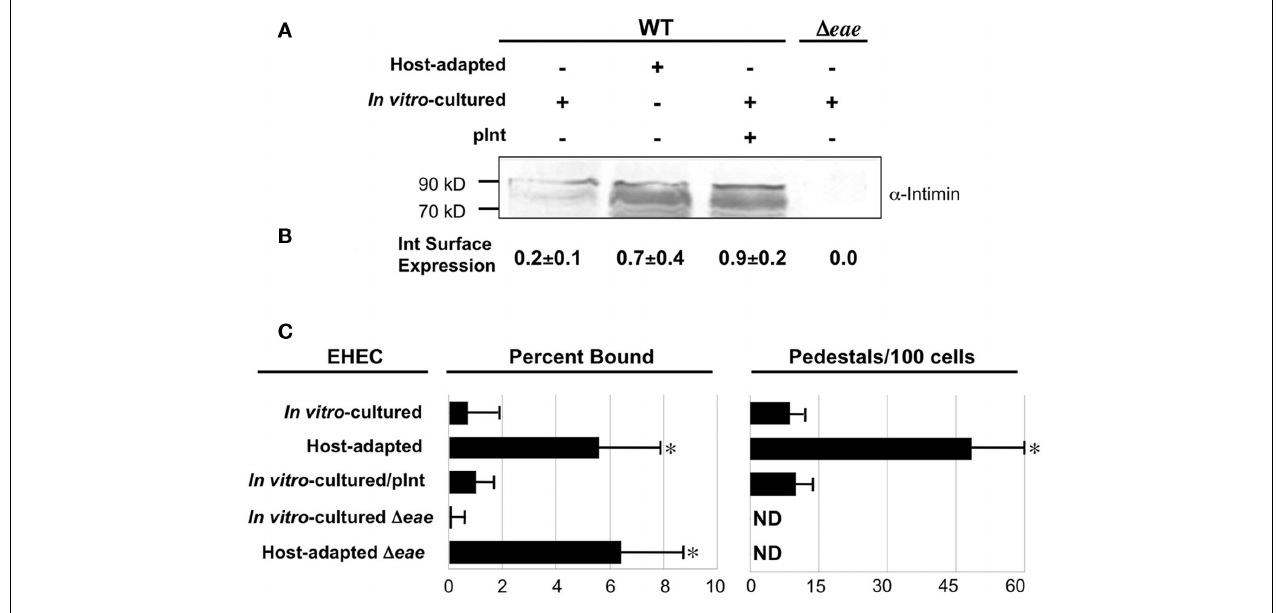
relative number of bound bacteria was normalized by ELISA using anti-O157 antiserum. Parallel microtiter wells were subjected to anti-intimin ELISA to determine relative intimin surface expression. Shown are the mean OD 600 values ( ± SD) of quadruplicate samples after subtraction of background (i.e., signal when the primary antibody was omitted) and normalized to bacterial number. (C) The percent of bacteria bound, determined by plating for viable counts, and the frequency of pedestal formation was determined as described in Figure 1 . ND, not detected. * P ≤ 0.05.